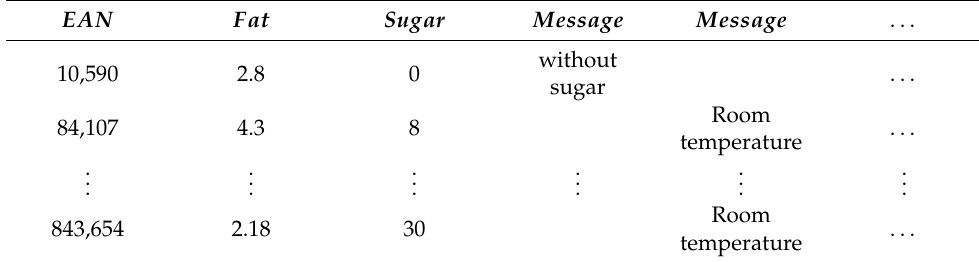
Table 3. Extract of the MDD-DS1.